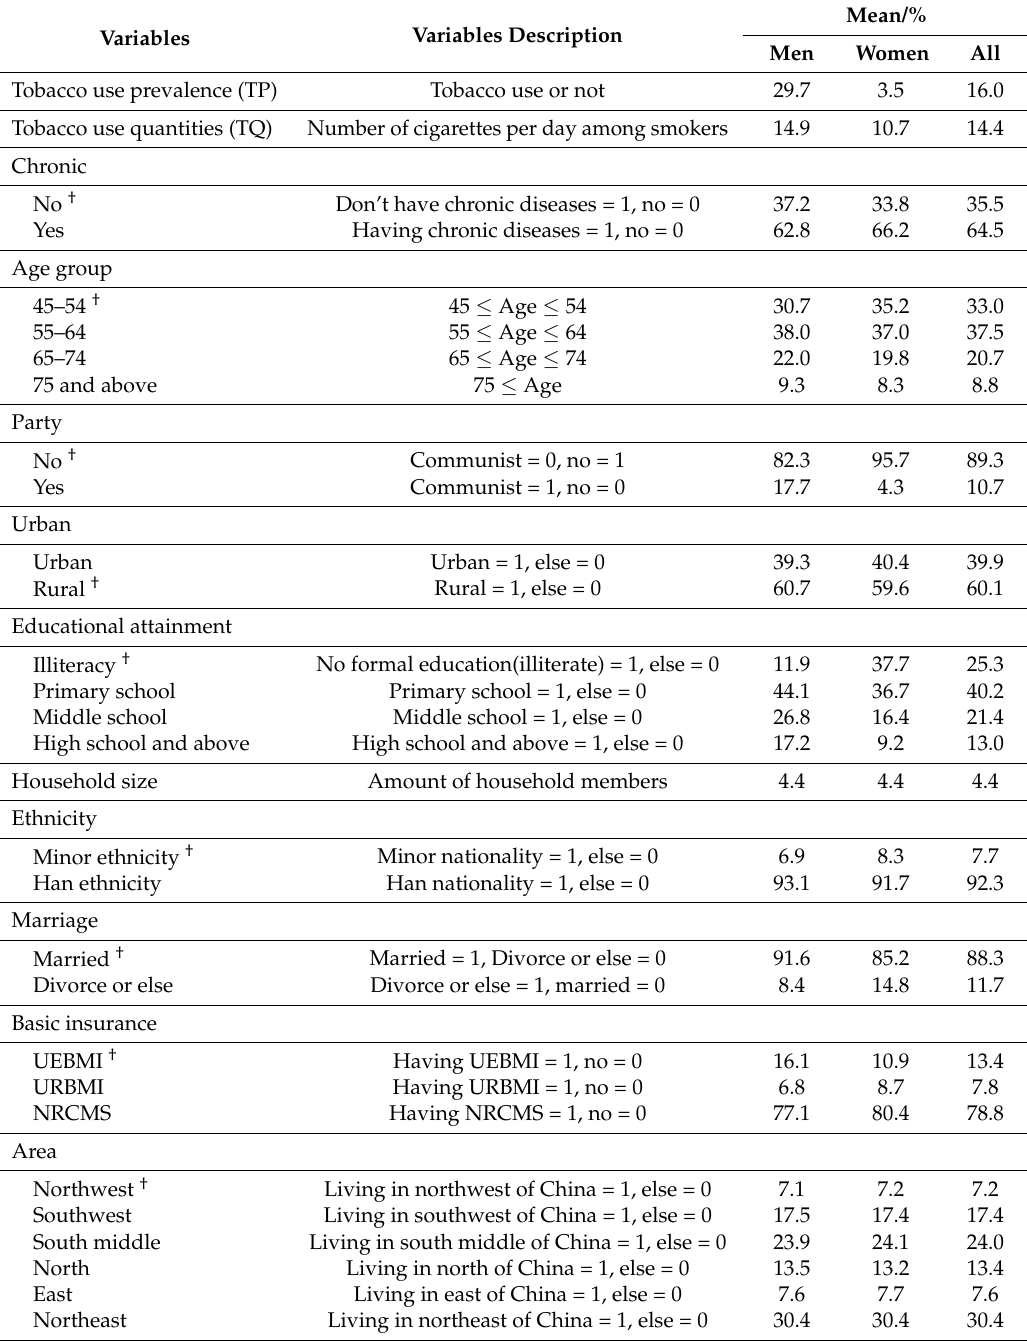
Table 1. Variables description and descriptive